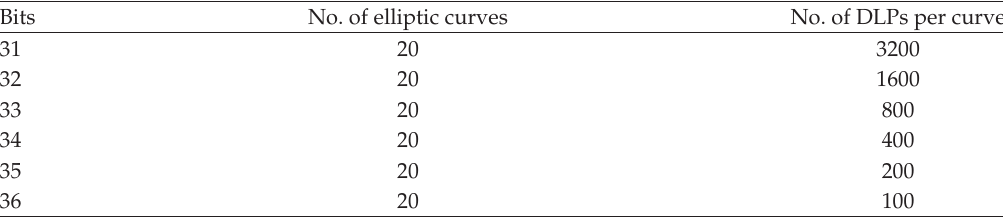
Table 1: Number of elliptic curves and instances of DLPs.